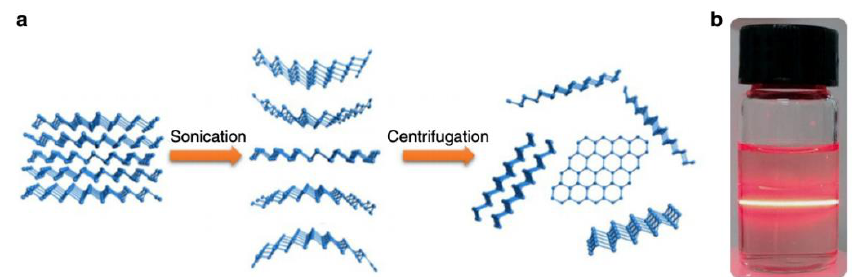
Figure 5. ( a ) Preparation of two-dimensional antimonene nanosheets. ( b ) Faraday–Tyndall effect